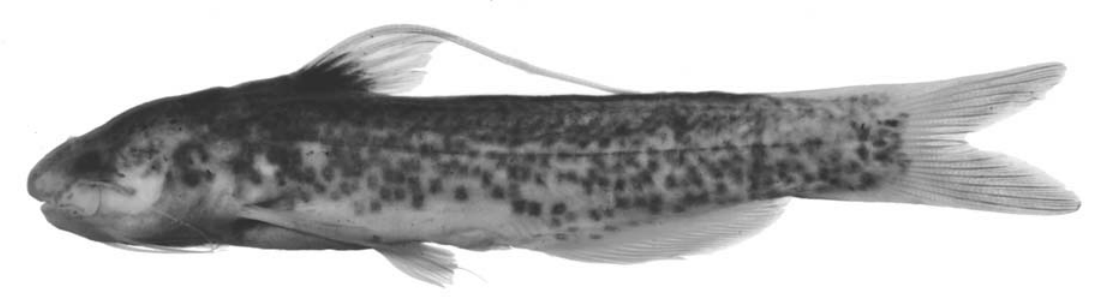
Fig. 6 . Cetopsidium morenoi , mature male, ANSP 165734, 43 mm SL; Venezuela, Apure, Caño Potrerito of río Cinaruco, 24